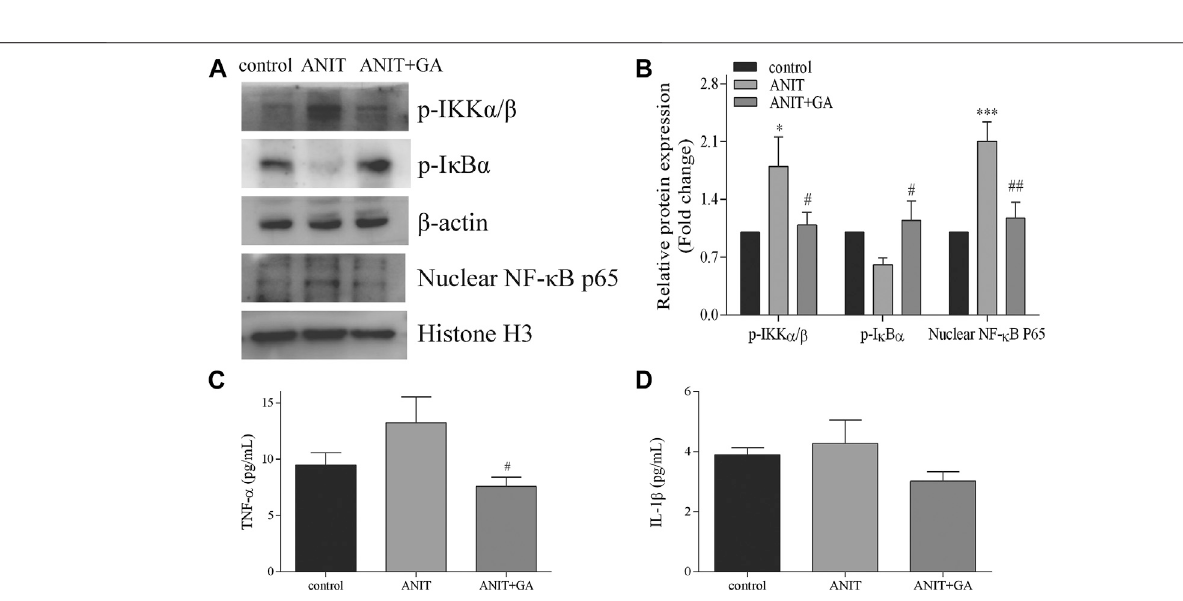
Frontiers in Pharmacology |